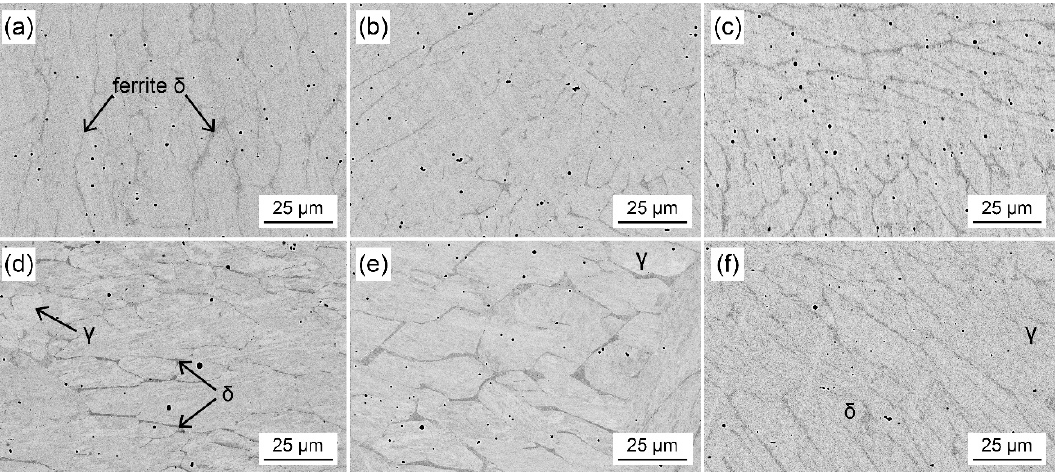
Figure 9. CBS-SEM images obtained at 1000x from W1 and W2: ( a ) as built in air; ( b ) built in air with TT1; ( c ) built in air with TT2; ( d ) as built in argon; ( e ) built in argon with TT1; ( f ) built in argon with TT2.